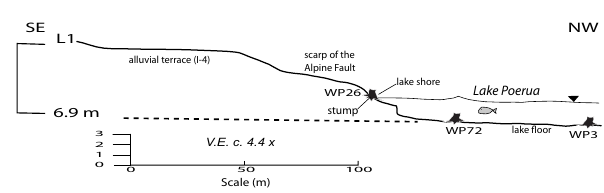
Fig. 8. Combined topographic profile constructed using a RTK-GPS (onland) and rod and tape (in lake). Profile L1 was measured from the road to stump WP3 on the lake floor. The height difference be- tween alluvial surface I-4 and the lake floor (ca. 6.9m) is equivalent to the vertical deformation across the Alpine Fault since the aban- donment of the I-4 surface (see Langridge et al., 2010).